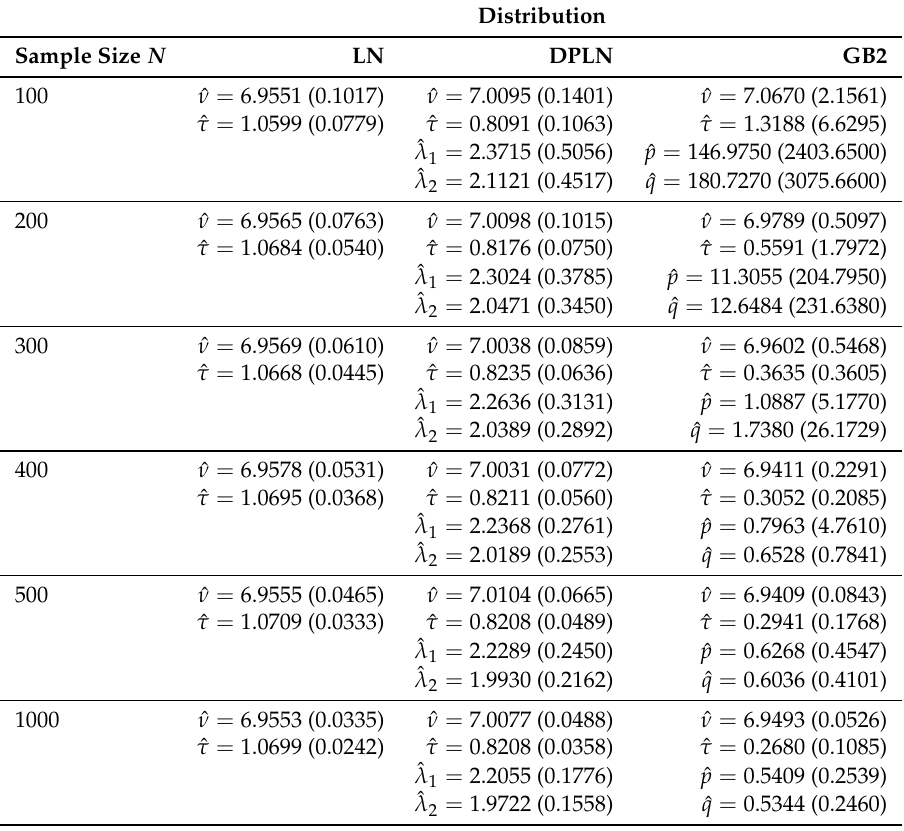
Table 3. Results of the simulation experiment involving 1000 simulations of data sets of size N , with standard errors shown in